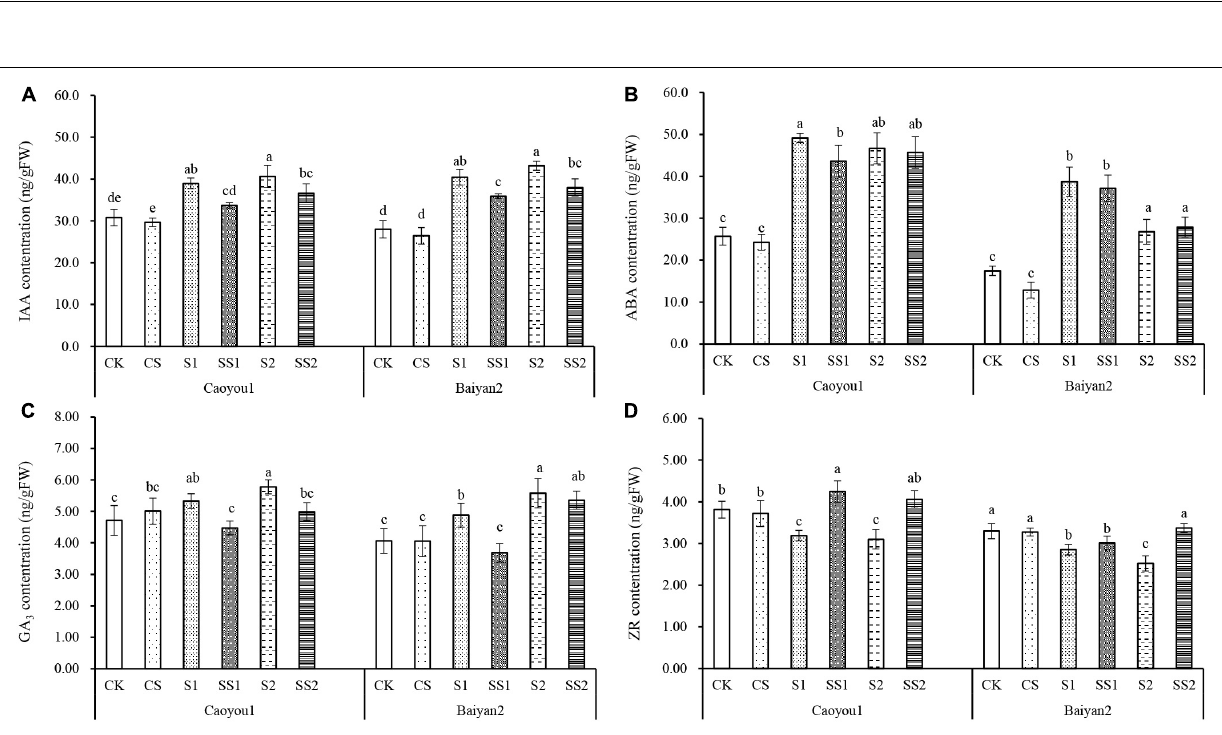
Frontiers in Plant Science |